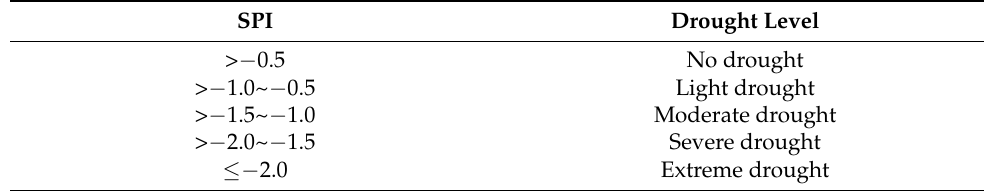
Table 1. SPI drought classification standard. SPI Drought